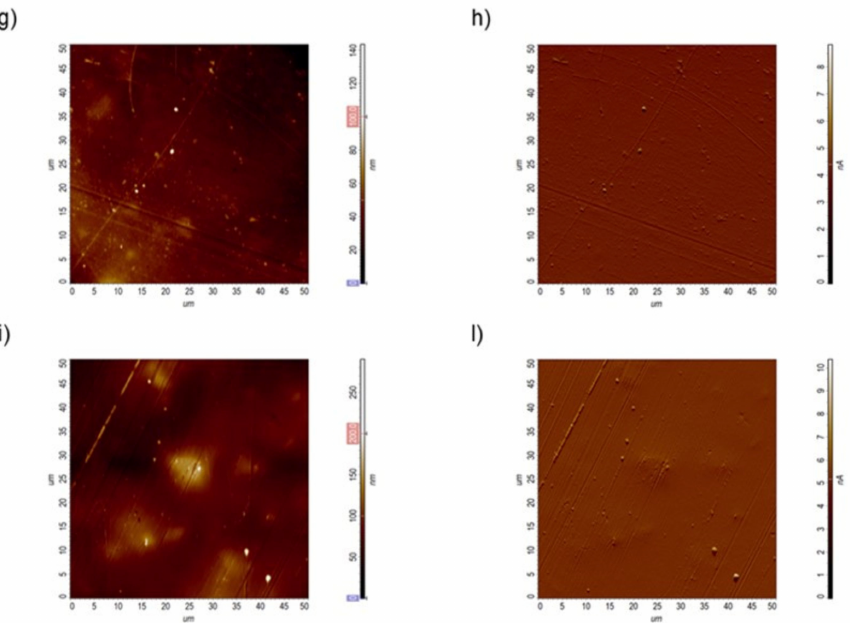
Figure 4. Representative topographical acquisitions obtained by atomic force microscopy in the height and deflection channel, obtained for PMMA ( a , b ), PMMA + TiO 2 NPs 1% ( c , d ), PMMA + TiO 2 NPs 3% ( e , f ), PMMA+ HNTs 1% ( g , h ), PMMA+ HNTs 3% ( i , l ) substrates.